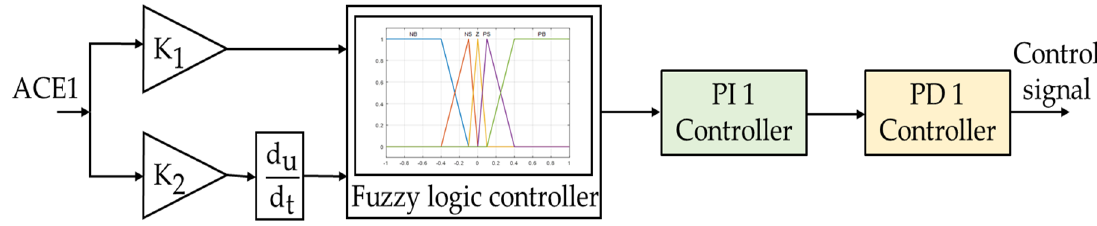
Figure 16. Block diagram of Fuzzy Cascade PI − PD controller configuration equipped in area one.